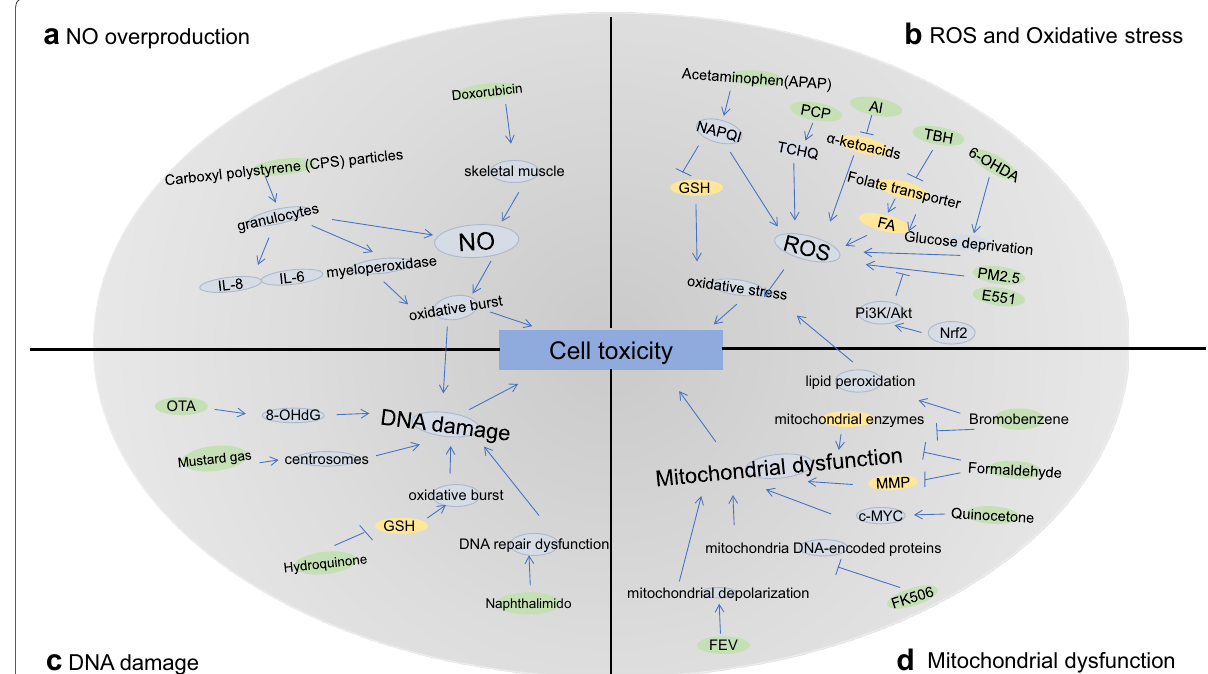
Fig. 1 The mechanism of cell toxicity mainly include: a NO or cytokines overproduction induced oxidative burst, b ROS and oxidative stress, c DNA damage, d Mitochondrial dysfunction. Toxicant were shown as